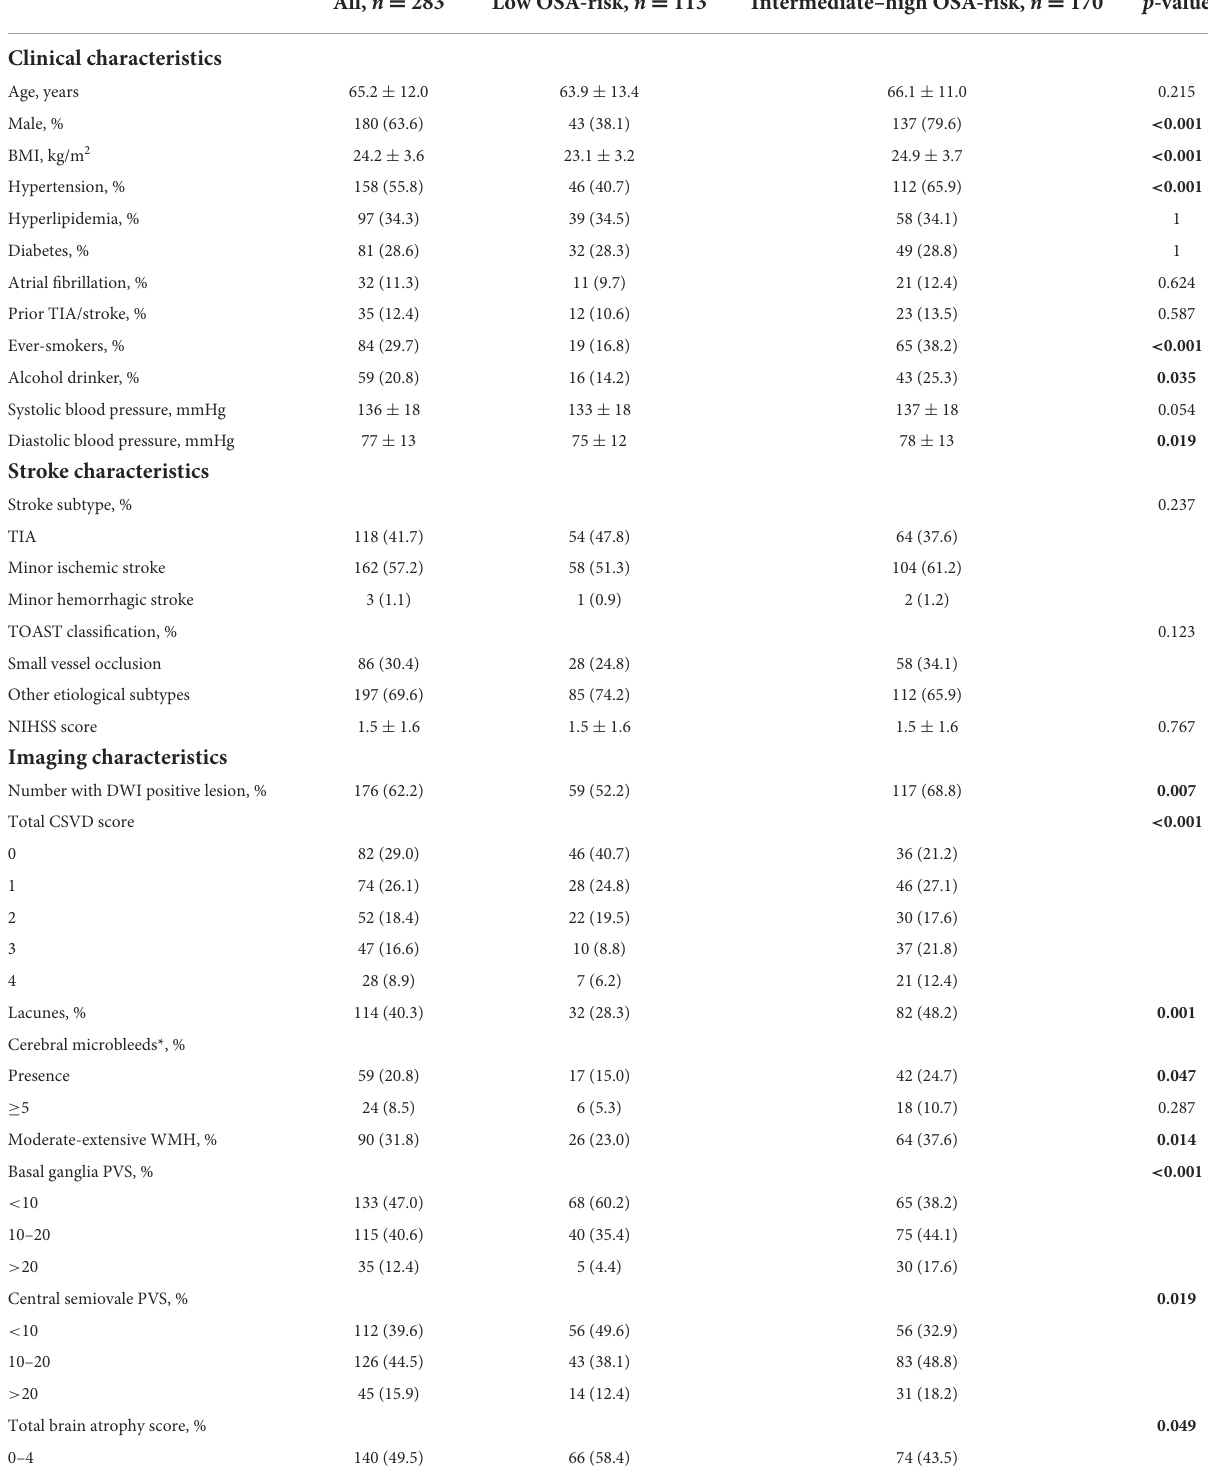
TABLE 1 Baseline clinical and imaging characteristics of the study population. All, n = 283 Low OSA-risk, n = 113 Intermediate–high OSA-risk, n = 170 p- value Clinical